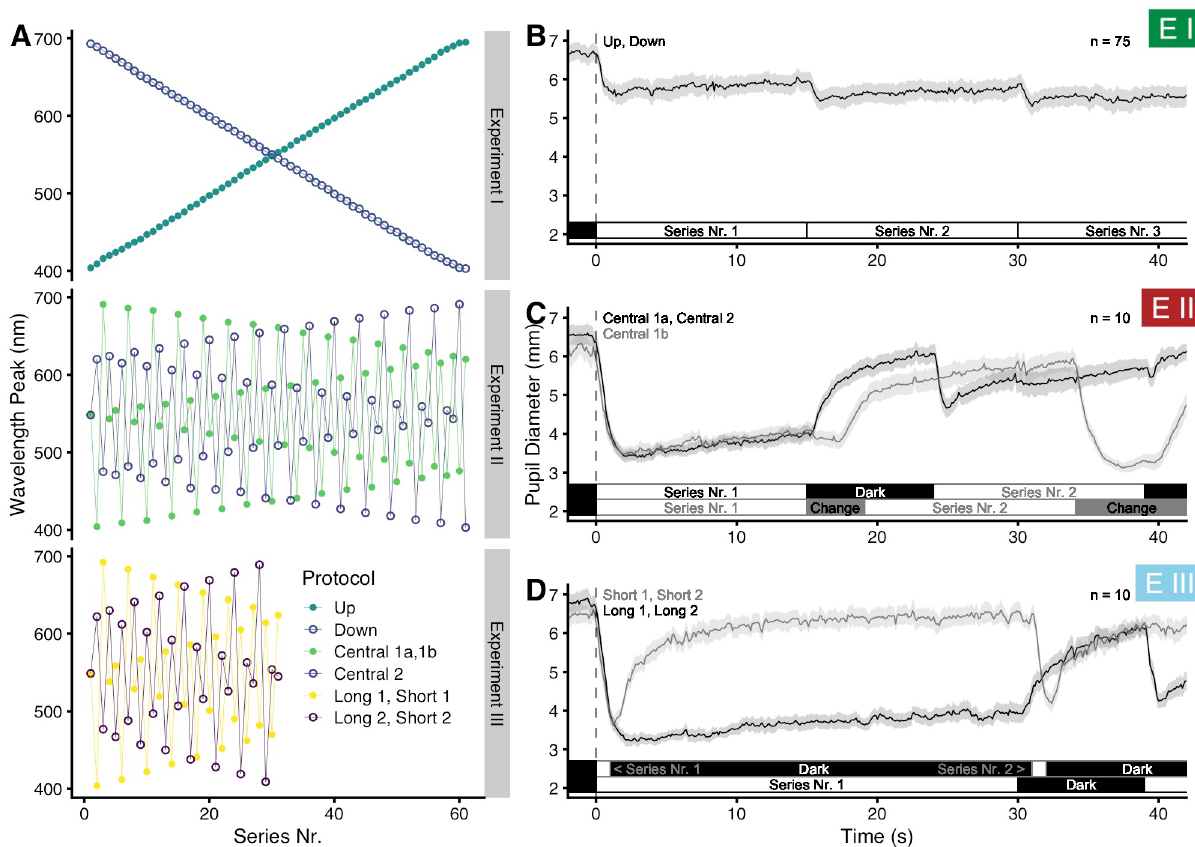
Fig 2. Experimental protocols. (A) Series of peak wavelengths for each experiment and protocol. A list for the respective order of wavelength peaks is available as part of the S3 File. (B, C, D) Schematics of the first 40 seconds of each experimental protocol. Light onset after dark adaptation occurs at zero seconds (dotted black line). Traces show the average pupil diameter, with a ribbon representing the SEM. For visual reasons, only one of the two protocols sharing the same procedure is shown. These are Up (B), Central 1a (C), and Short 1 and Long 1